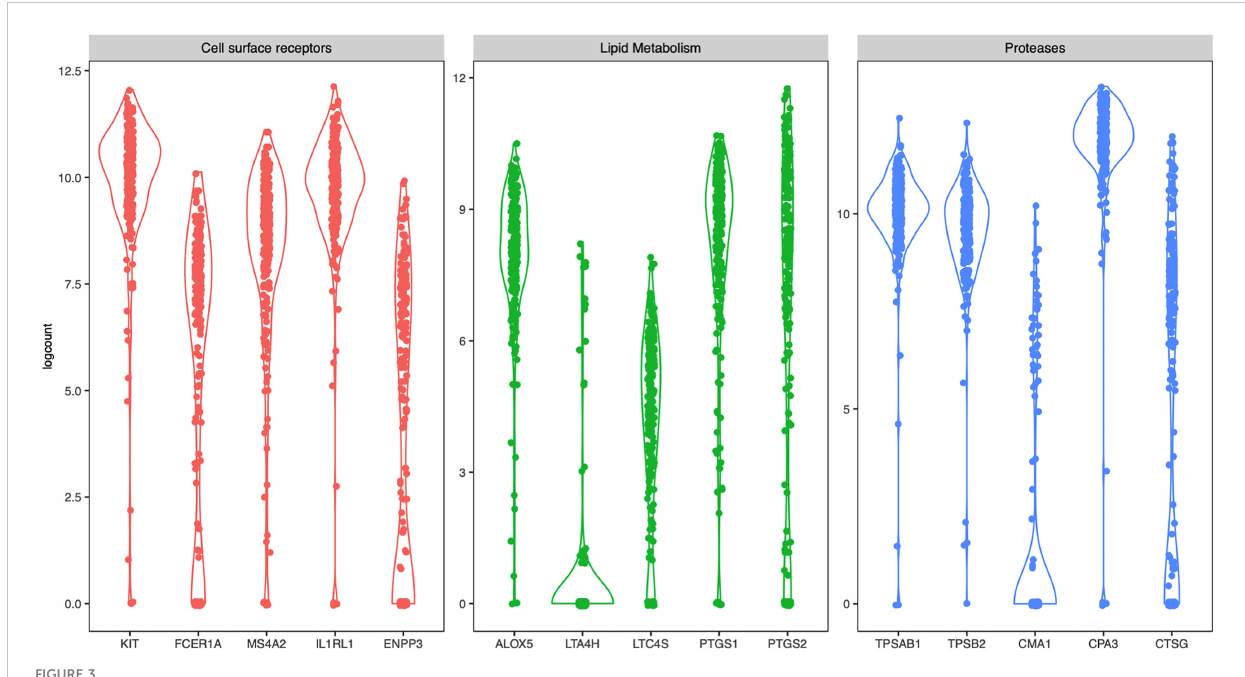
FIGURE 3 Violin plots of selected mast cells signature genes from all four